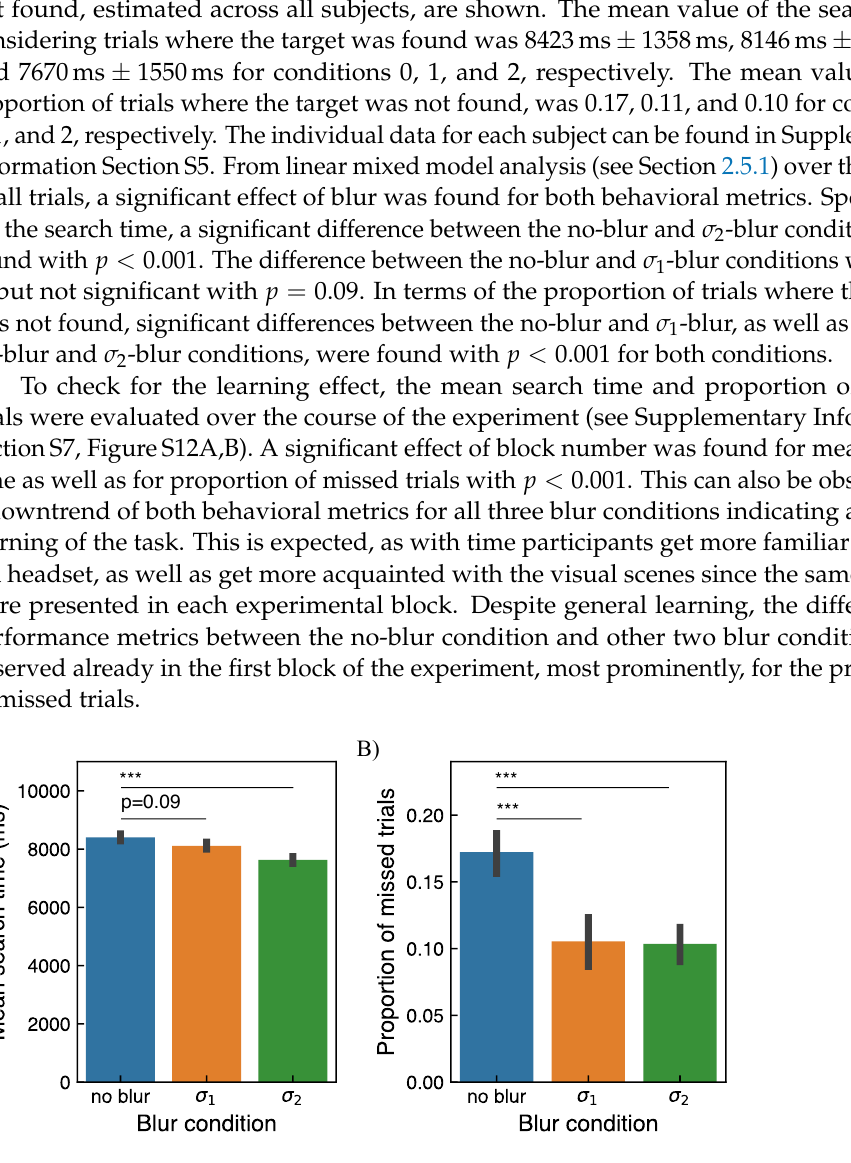
Figure 8. ( A ) An estimate of mean search time in each blur condition. The mean search time was computed for each subject by averaging the search time over the number of trials where the target was found. ( B ) An estimate of the proportion of trials where the target was not found in each blur condition. The bar plots represent data from 20 subjects. The error bars show the standard error of the mean. The indicators of significant differences obtained from the linear mixed model analysis are *: p < 0.05, **: p < 0.005, ***: p < 0.001. For non-significant differences, the p -value is